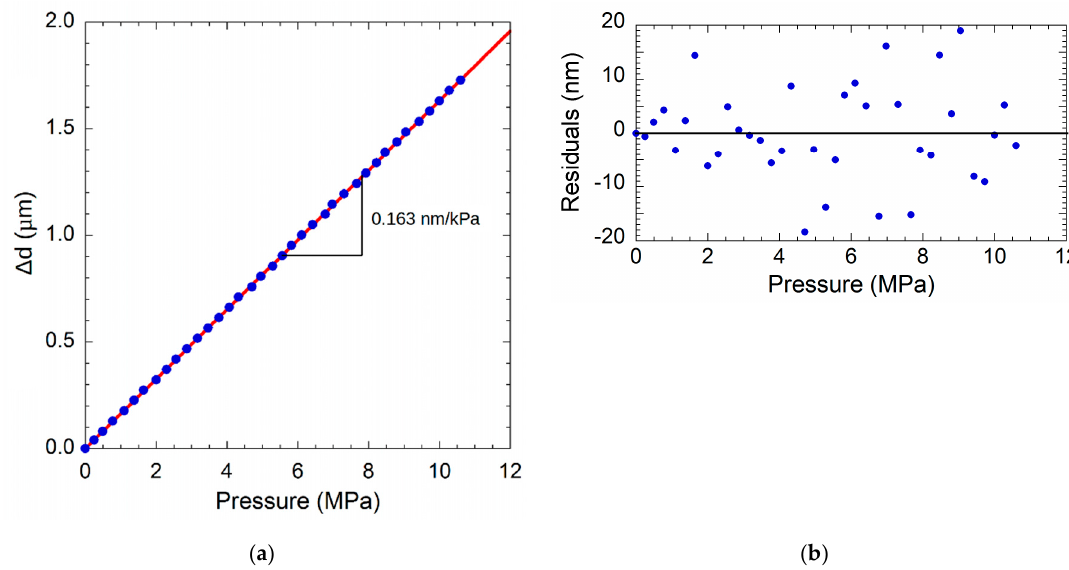
Figure 8. ( a ) Diaphragm deflection as a function of pressure for a membrane 160 µm thick. ( b ) Residuals calculated by the difference of values of ( a ) and those calculated by linear best fit of data.